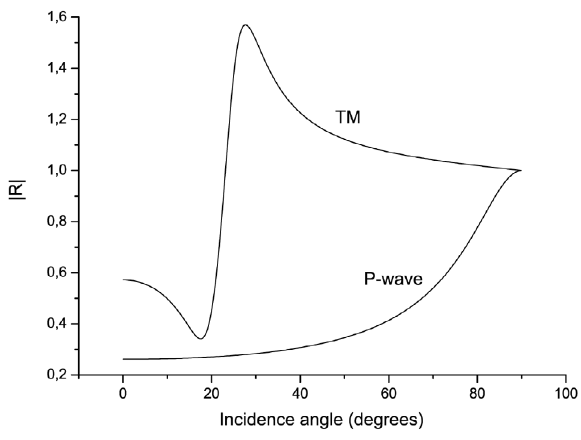
Figure 9. Absolute value of the TM-wave and P-wave reflection co- efficients as a function of the incidence angle, corresponding to a sandstone layer saturated with supercritical gas embedded in brine- saturated